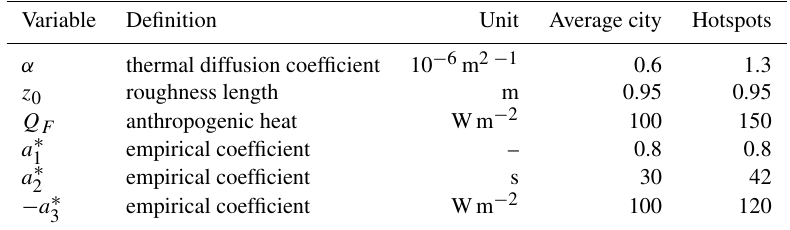
Table 2. Additional input data for the soil temperature model (source: Agudelo-Vera et al., 2015a).